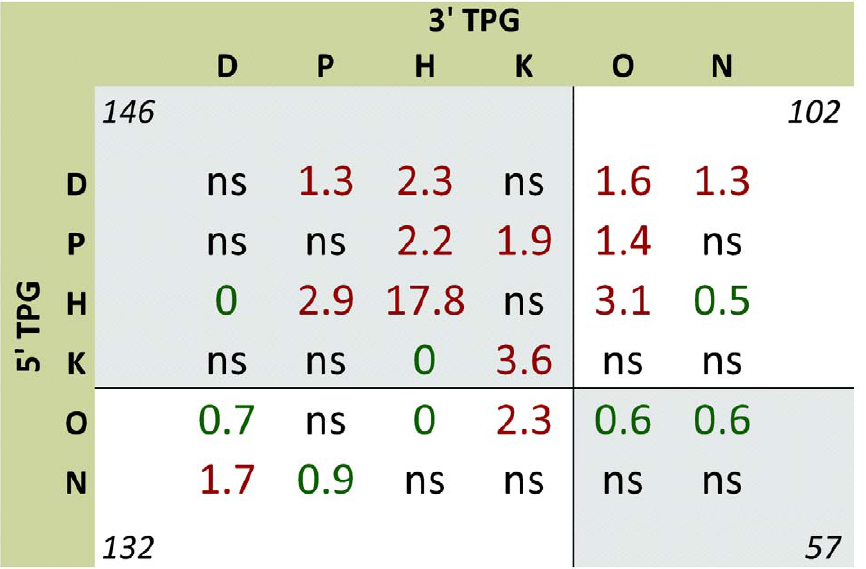
Figure 5. Co-occurrence matrix of various functional classes of domains in hematological translocations. Values in the table show ratio of real count to mean count of permuted data, non-significant ratios are masked as ns. Green and red values represent significantly under- and over- represented co-occurrences, respectively (using 10% FDR cutoff for p-values estimated with 10 6 random permutations). Values at margins indicate total numbers of translocations with domains of corresponding sets (type 1 domains D, P, H or K and type 2 domains O and N). Types of 5 9 TPG and 3 9 TPG domain sets are dependent (P=0.02, two-sided Fisher exact test). Translocations where both TPGs have type 2 domains constitute 13% of all translocations and are under-represented 0.78 fold (P , 10 2 6 , permutation